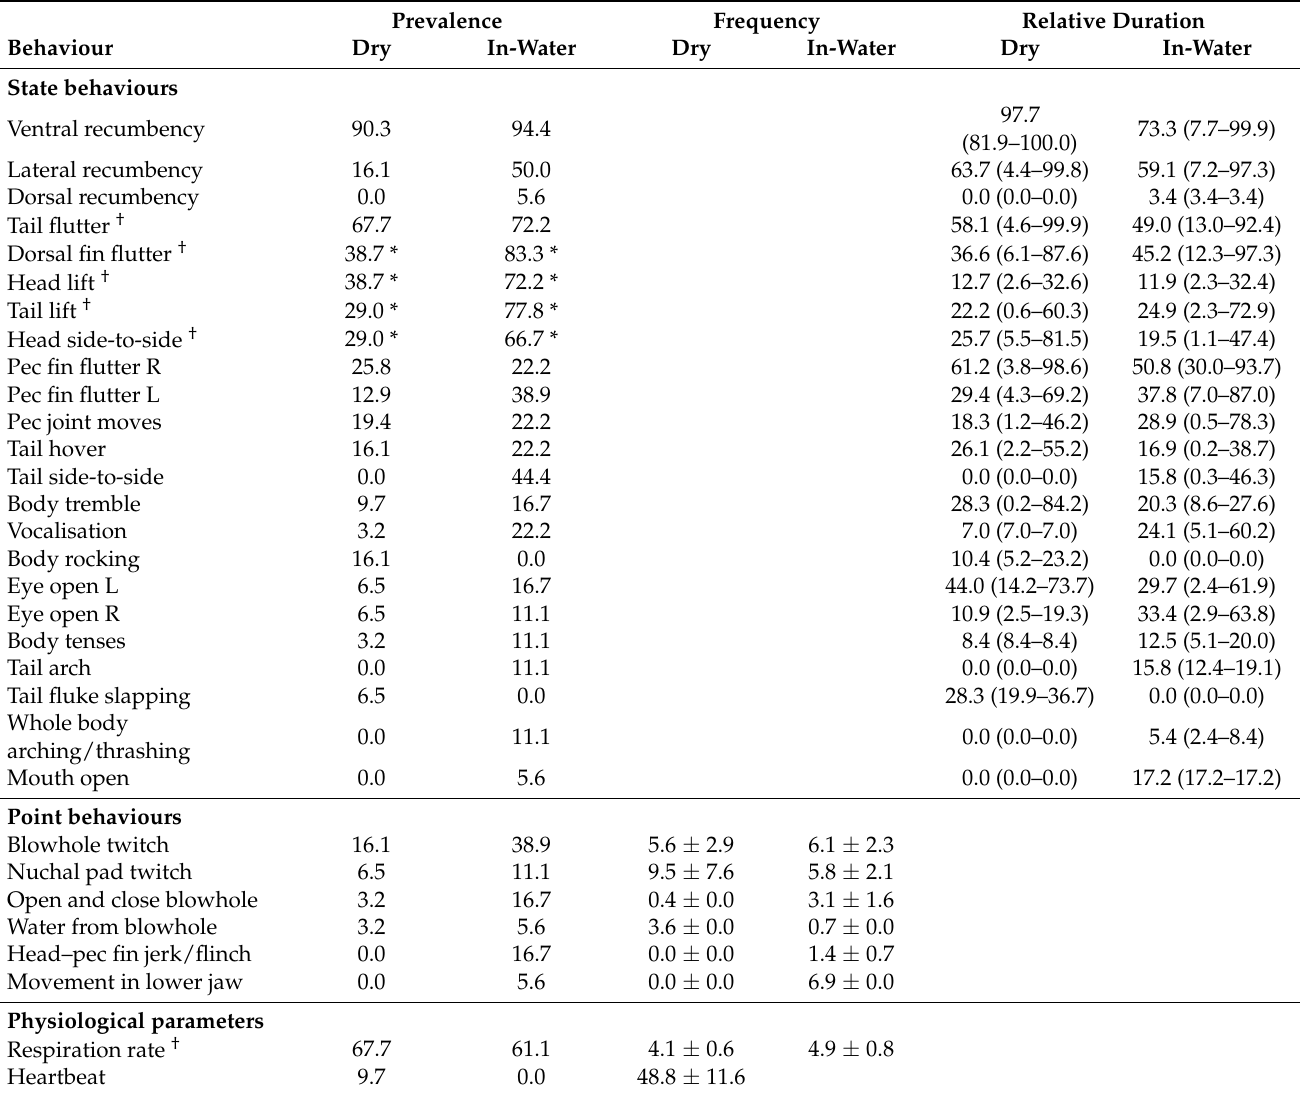
Table 5. Observed prevalence (% of individuals displaying behaviour), mean frequency (rate/minute) ± SEM of point behaviours, and mean relative duration (% of monitored time and range) of state behaviours for only long-finned pilot whales that showed the behaviour, from a total of 31 dry- and 18 in-water-stranded individuals across 11 stranding events on the New Zealand coast between 2010 and March 2022. † Only prevalent indicators could be tested for statistical differences; * significant difference ( α = 0.05) in prevalence between stranding